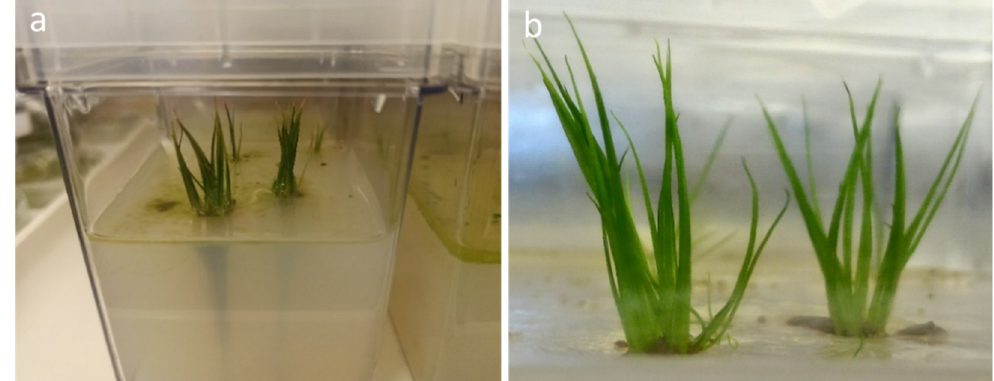
Figure 5. Sporelings of Isoëtes sabatina transplanted in plant culture containers Magenta TM GA7 on water-agar (1%) medium (4 cm high) with ( a ) visible roots and ( b ) abundant development of new leaves after 1-year culture.